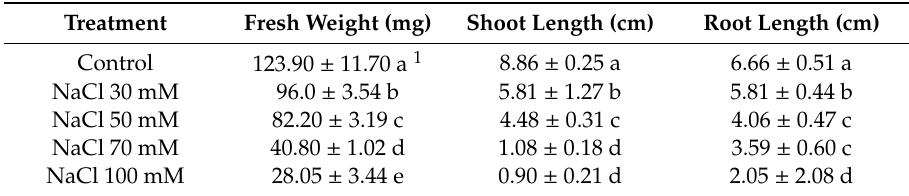
Table 1. E ff ect of NaCl treatment on the growth of Tartary buckwheat